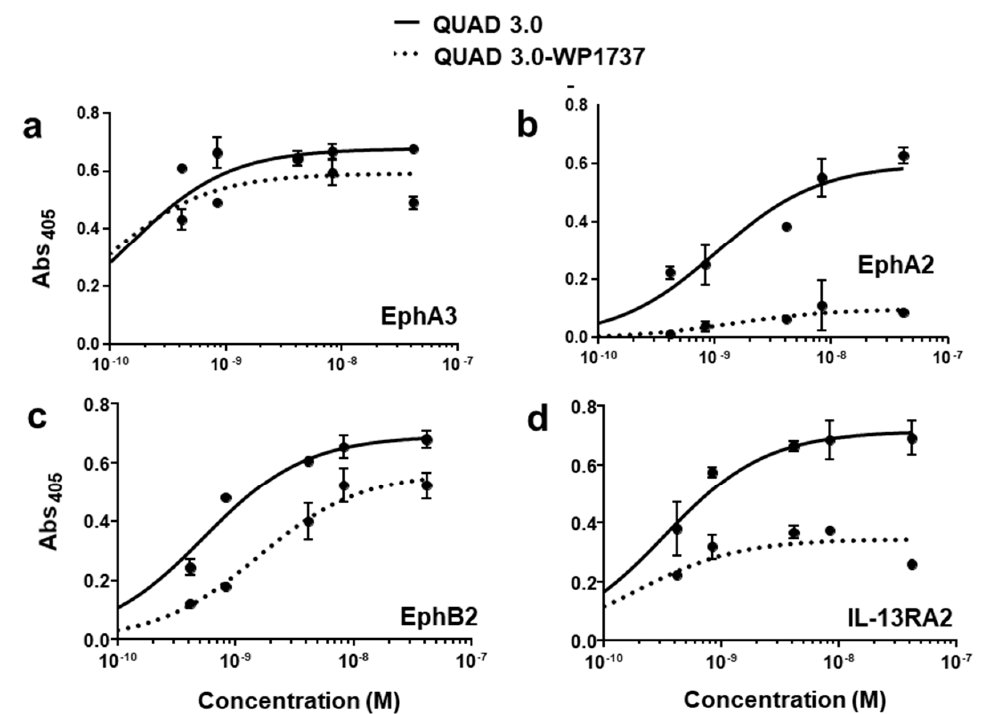
Figure 3. QUAD 3.0-WP1737 binding to EphA3, EphA2, EphB2, and IL-13RA2 receptors. ELISA assay showing the binding of unconjugated QUAD 3.0 and QUAD 3.0-WP1737 conjugate to ( a ) EphA3; ( b ) EphA2; ( c ) EphB2; and ( d ) IL-13RA2 receptor proteins.